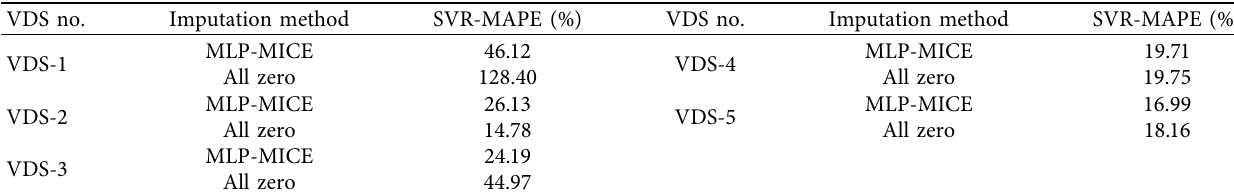
Table 8: Prediction experiment results of other